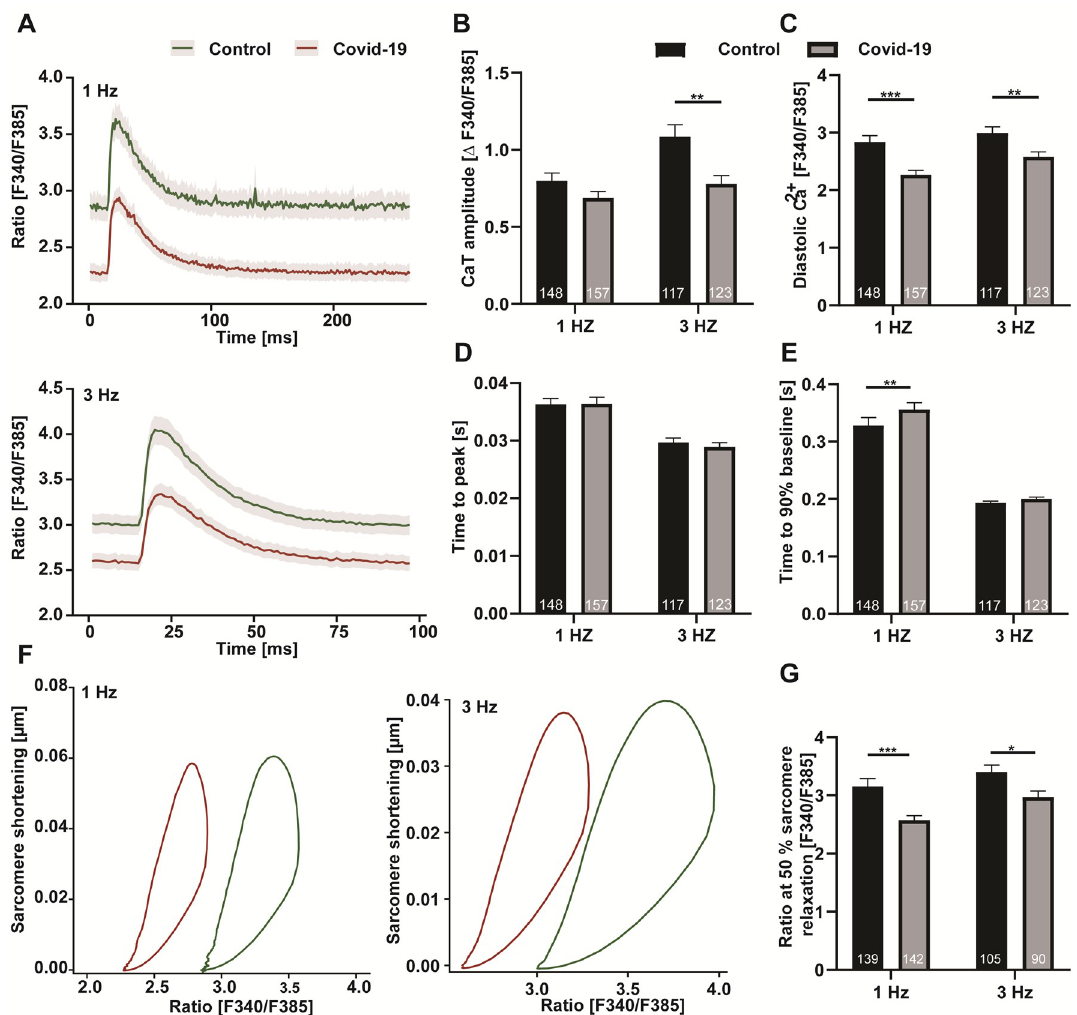
Fig 2. Ca 2+ signaling during excitation-contraction coupling (rat) after 60 minutes incubation with control (black) or COVID19 (grey) serum. (A) Ca 2+ transients averaged over all cells per group at 1 Hz (upper) and 3 Hz (lower) electric stimulation and 1